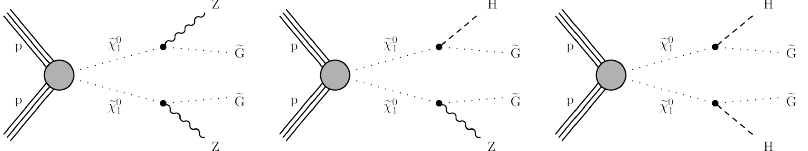
Figure 13: A GMSB model with higgsino pair production. The ˜ χ 0 nearly mass degenerate with ˜ χ 0